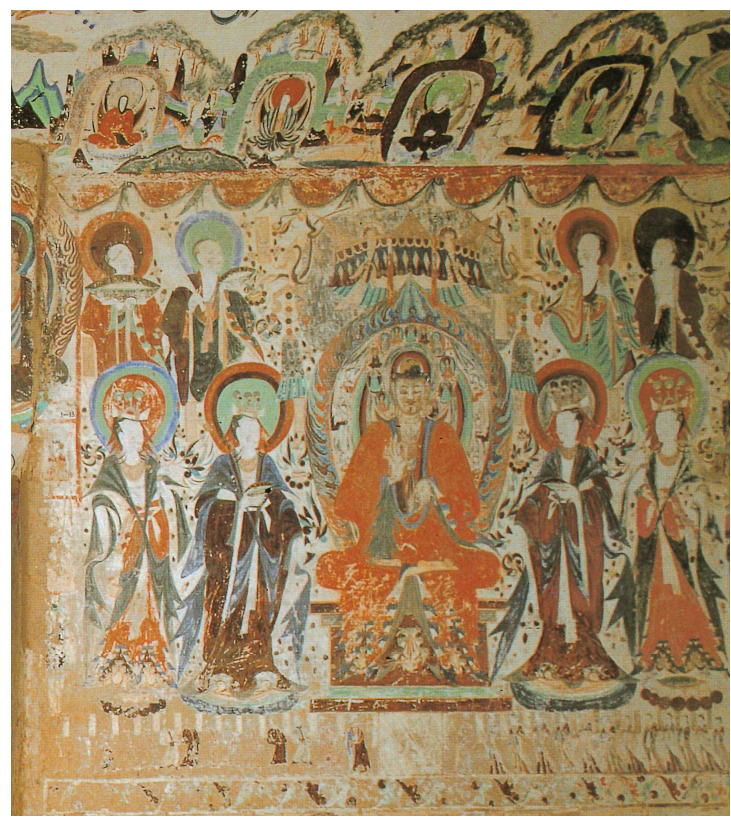
Figure 19. Buddhas and bodhisattvas, north side of east wall, Mogao cave 285, Western Wei dynasty (535–56). (Li 2011, pl. 139). ©Wenwu Press. This figure published with permission of Wenwu Press and cannot be used or copied without their